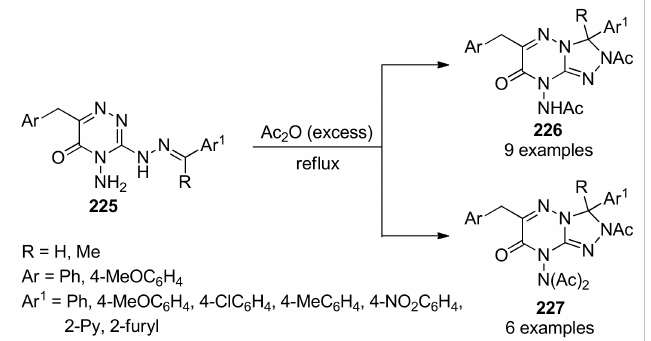
Scheme 88. Multicomponent synthesis of polyacetylated fused 1,2,4-triazine derivatives 226 / 227 to